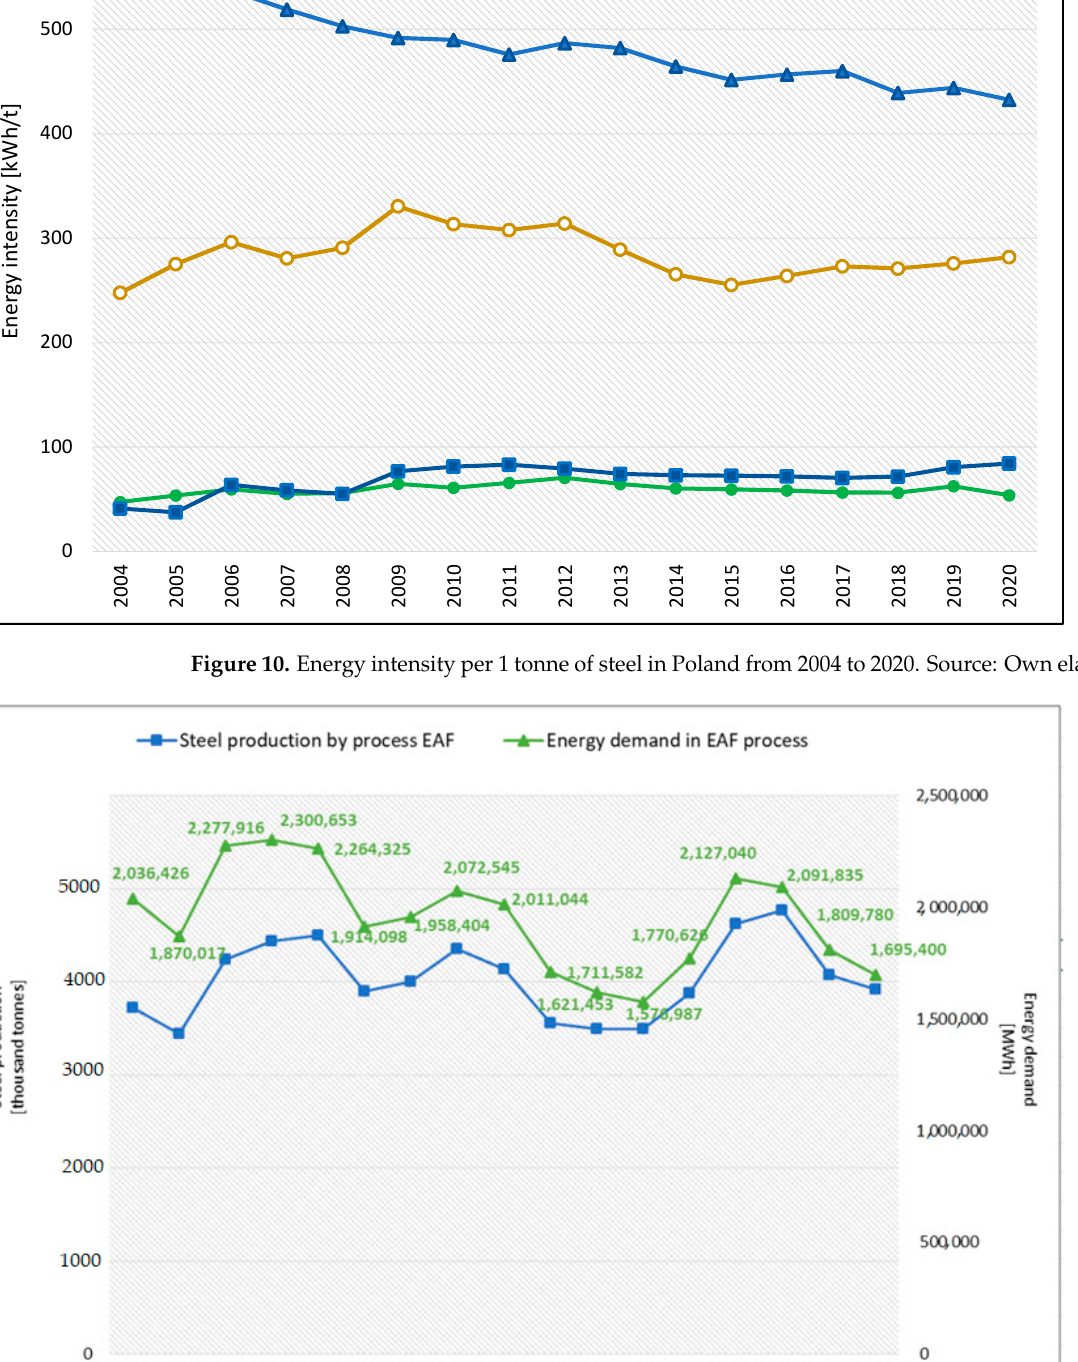
Figure 12. Total energy demand in the BOF process in Poland from 2004 to 2020. Source: Own elab- oration.